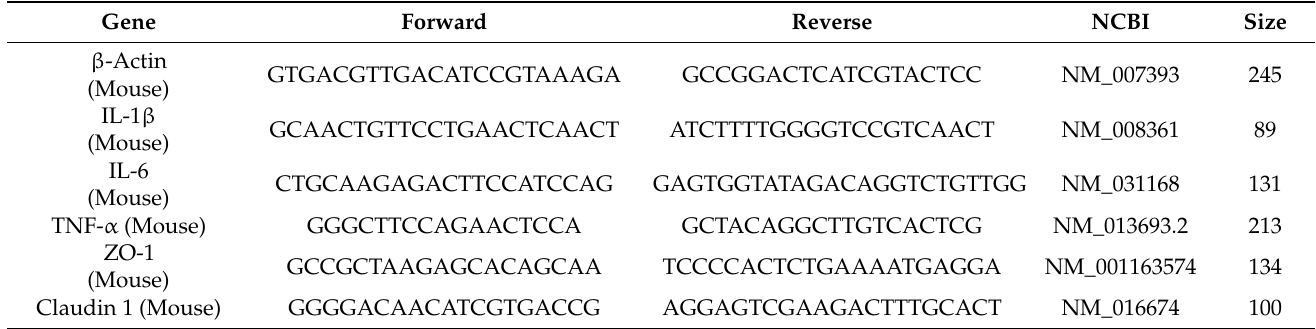
Table 1. Primers for mRNA